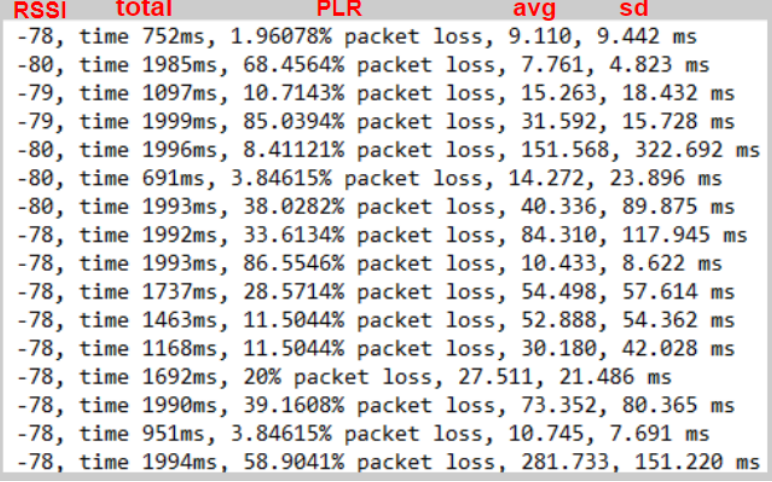
Figure 4. Evaluation of the wireless